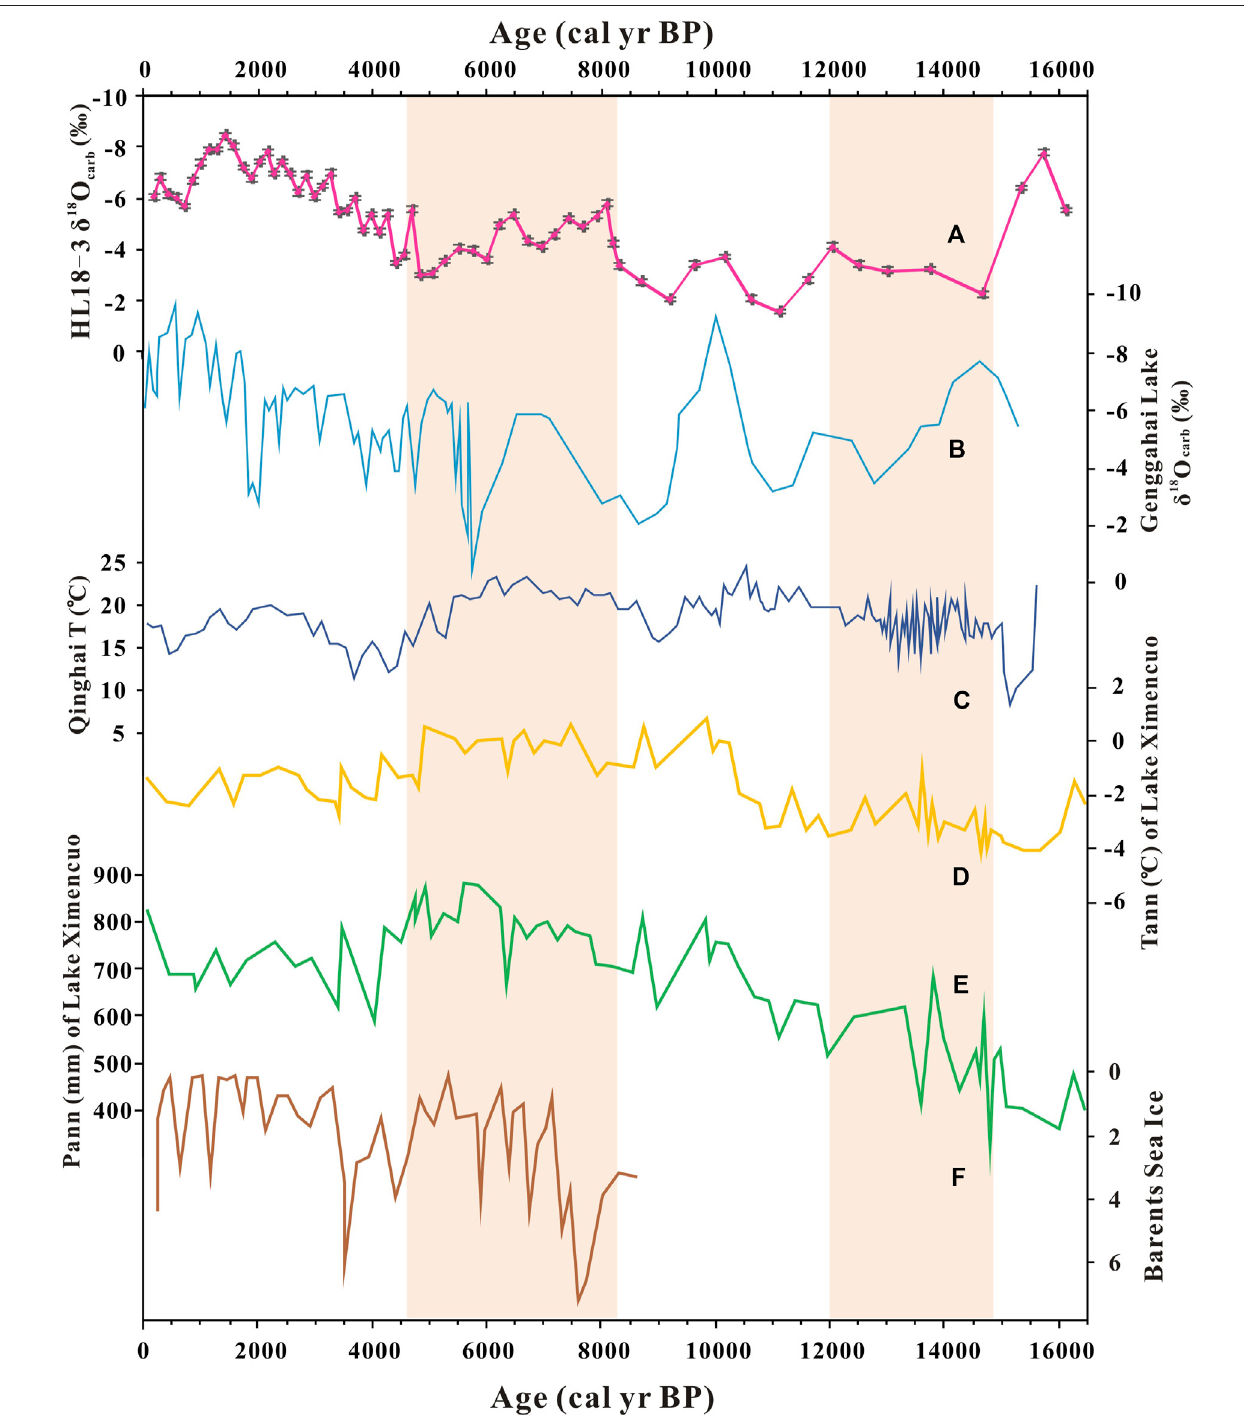
FIGURE 7 | Comparison of regional climate records. (A) The δ 18 O carb in the HL18-3 core. (B) The δ 18 O carb Genggahai Lake core (Qiang et al., 2017). (C) U K 37 inferred temperature record at Lake Qinghai for the past 16 ka (Hou et al., 2016). (D) Pollen-based T ann (mean annual temperature) from Lake Ximen Cuo on the northeastern TP (Herzschuh et al., 2014). (E) Pollen-based P ann (mean annual precipitation) from Lake Ximen Cuo on the northeastern TP (Herzschuh et al., 2014). (F) Arctic sea ice extent (de Vernal et al., 2013).